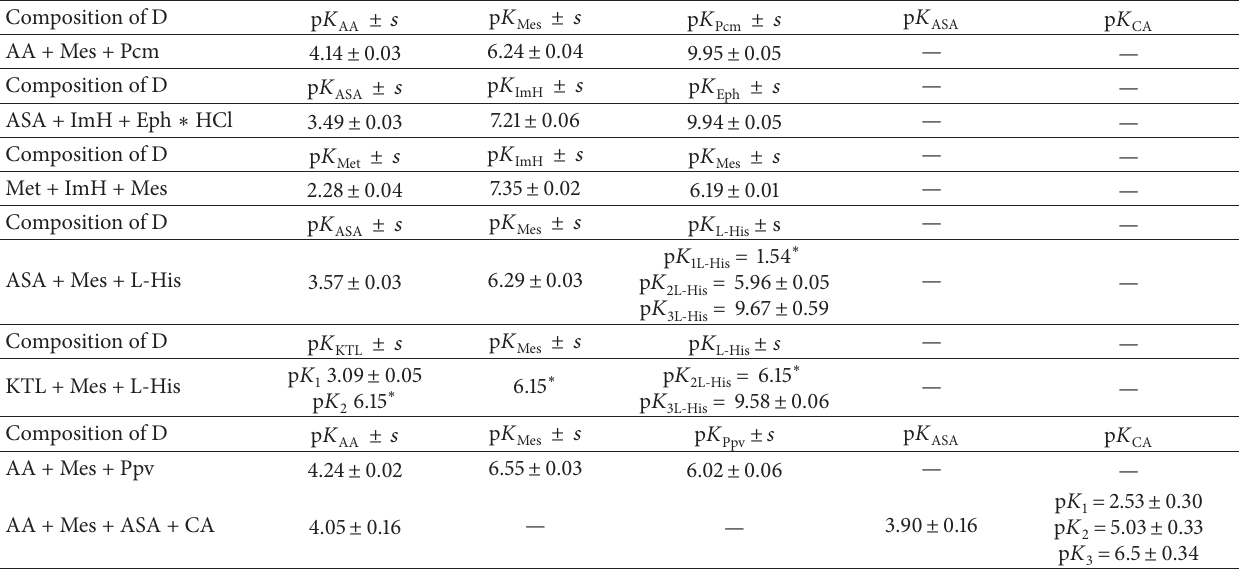
Table 10: The p 𝐾 ’s values of compounds with pharmaceutical importance determined in the mixture containing other weak electrolytes a 25 ∘ C.